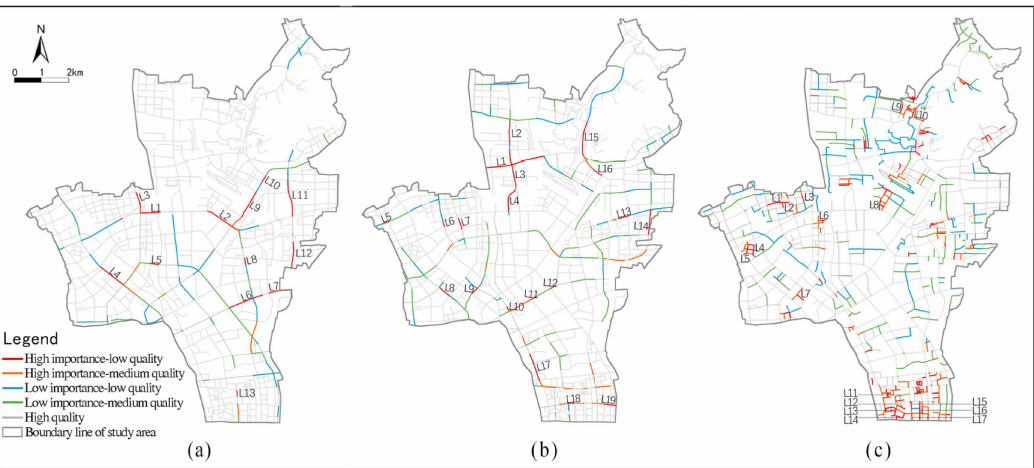
Figure 21. The “importance–quality” evaluation results and the spatial distribution of priority renewal streets in the near future. ( a ) Arterial road; ( b ) Secondary trunk road; ( c ) Branch